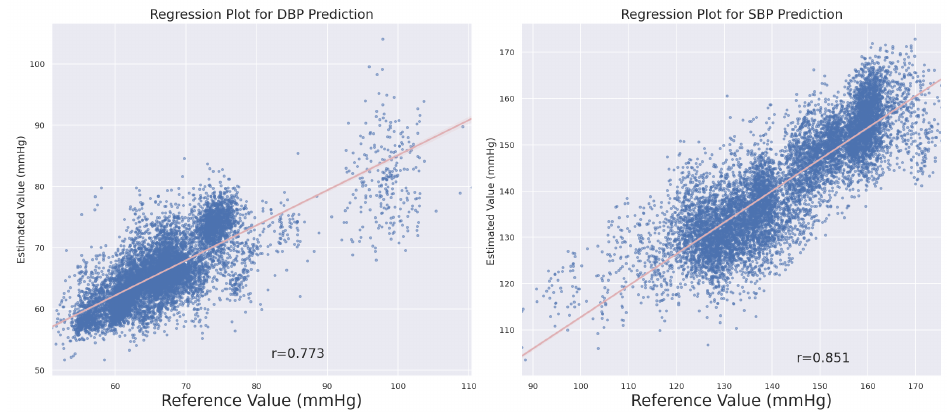
Figure 4. Regression plots for BP